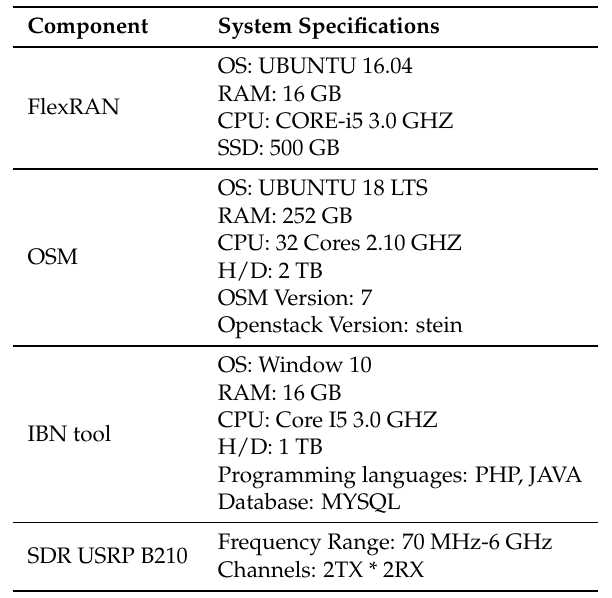
Table 2. Test-bed components configurations and